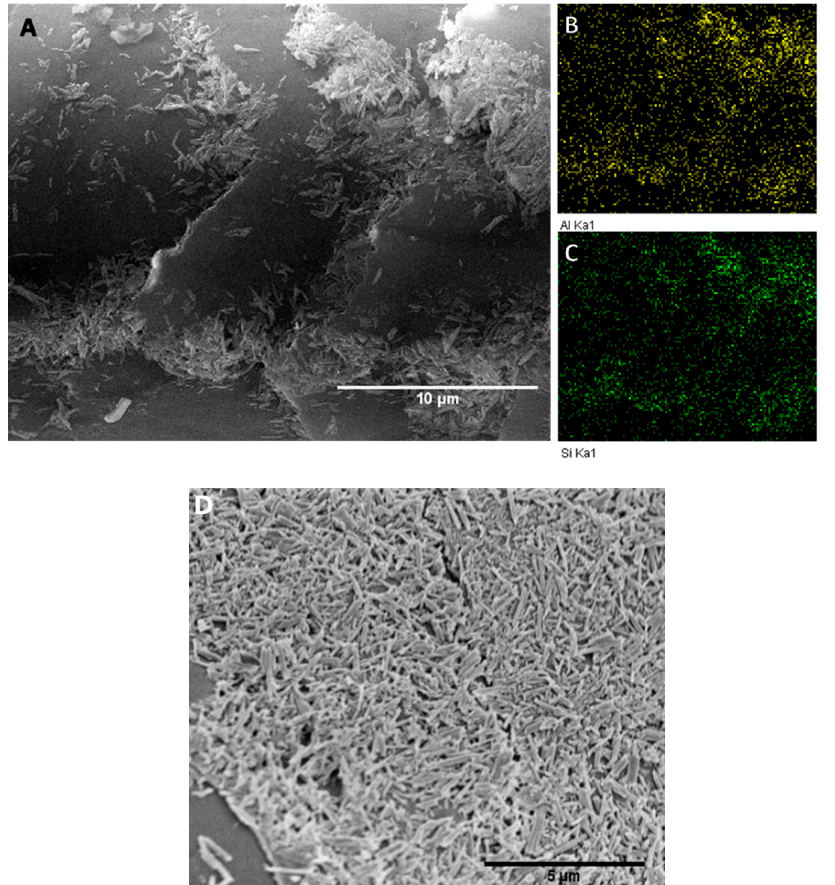
Figure 2. SEM image of halloysite coating in cuticle vicinity ( A ) and EDX mapping-aluminium ( B ) and silica ( C ) mapped of hair coated with halloysite. Al and Si areas represent a distribution of the nanotubes. ( D ) SEM image of hair completely coated with halloysite.